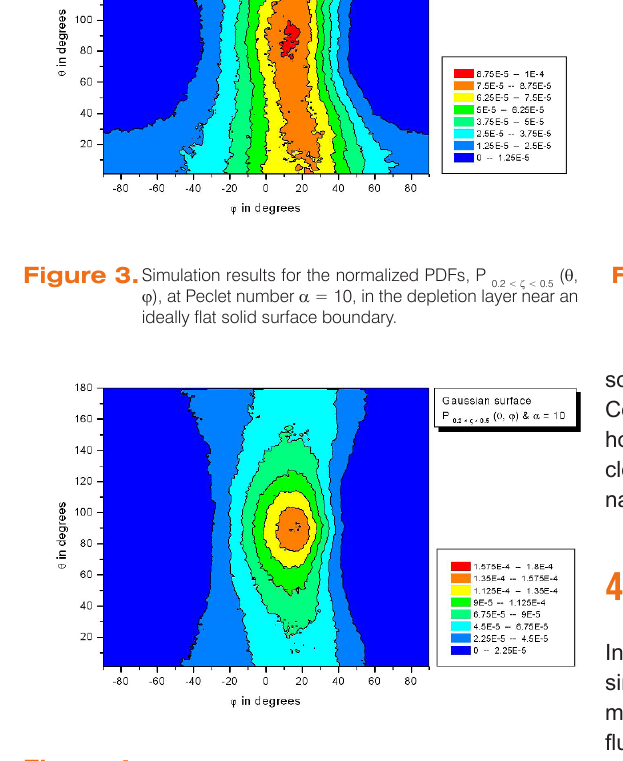
Figure 4. Simulation results as in Fig. 2, near a Gaussian rough solid surface boundary.